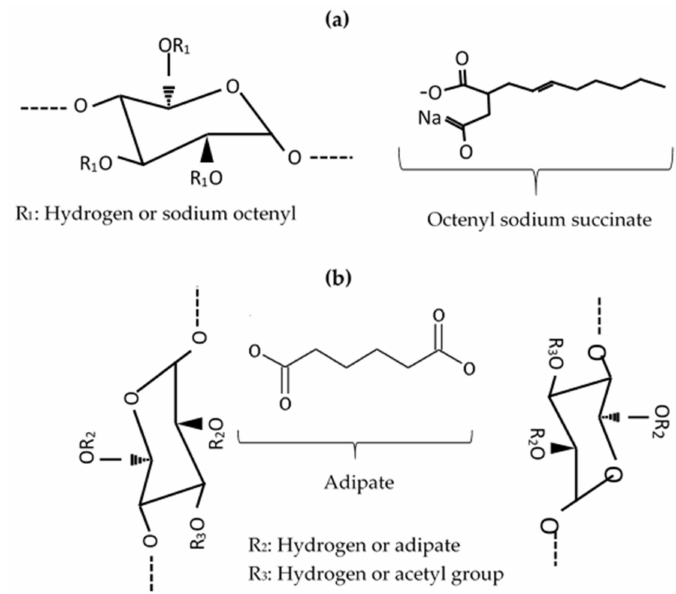
Figure 1. Chemical structures of starches: ( a ) Sodium octenyl succinate (SOS) R 2 = CO-(CH 2 ) 4 -CO and R 3 = –COCH 3 (modified from